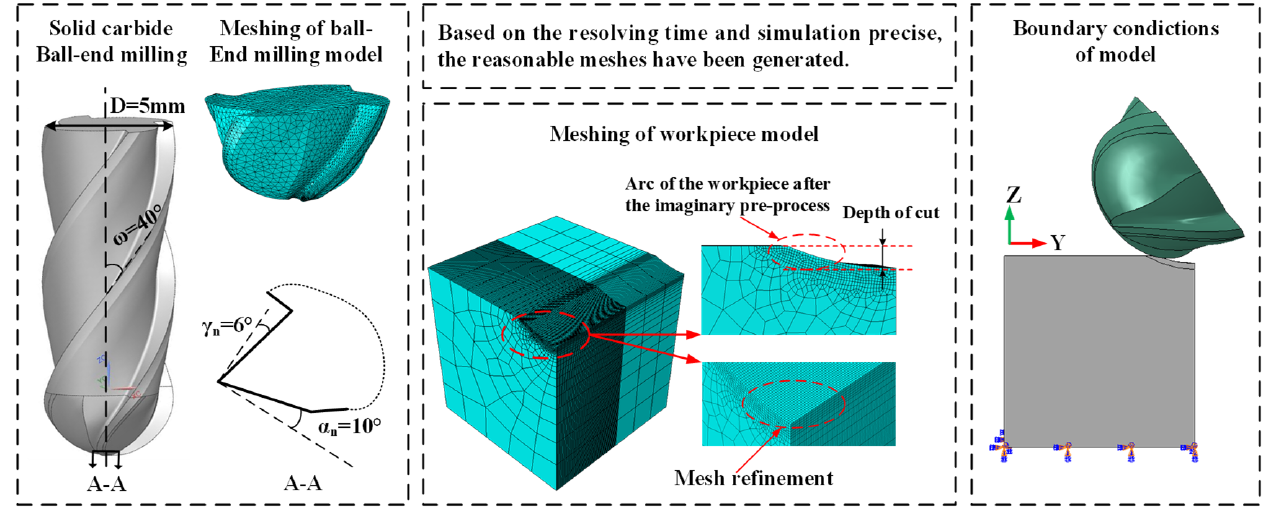
Figure 1. Numerical model for multi-axis milling of Ti-6Al-4V alloy.